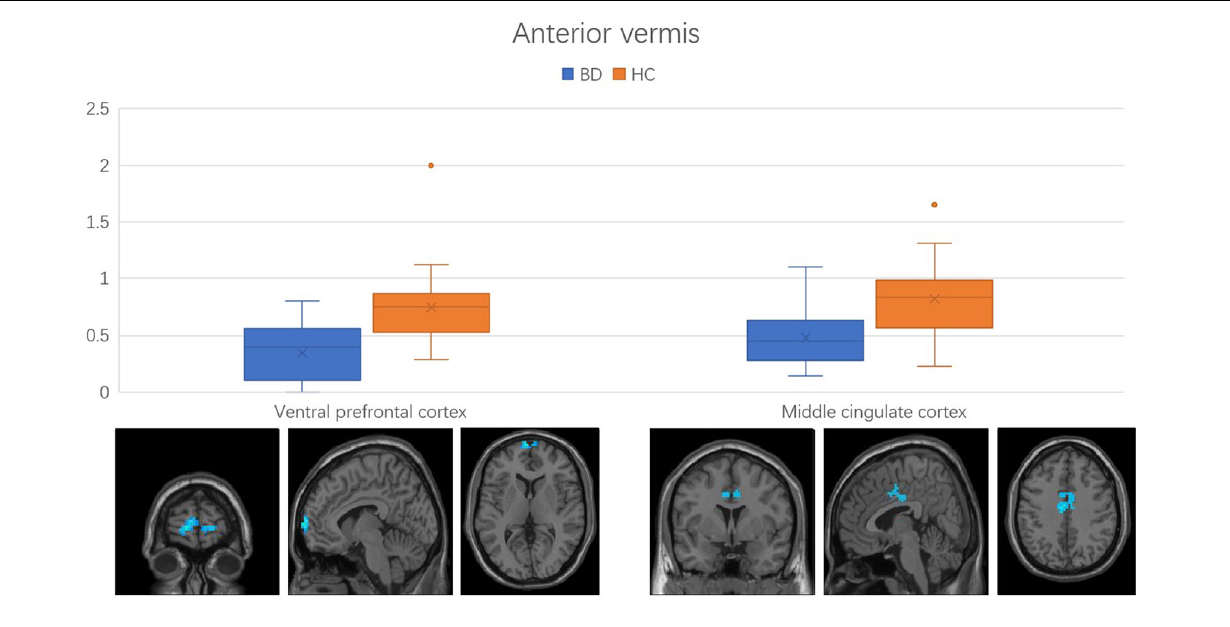
FIGURE 2 | Functional connectivity between anterior vermis and ventral prefrontal cortex, middle cingulate cortex in the comparison between bipolar disorder (BD) and healthy controls (HC) groups. Error bars represent the standard deviation of Z values at the peak voxel. BD, bipolar disorder; HC, healthy control.